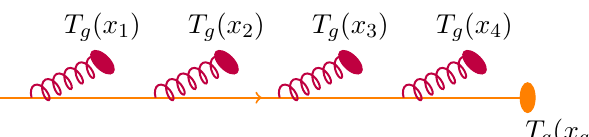
Figure 8 . An eikonal quark emitting soft, collinear gluons. For the calculation of a track-based observable, each gluon emission, as well as the (cid:12)nal quark, must be weighted with the appropriate track